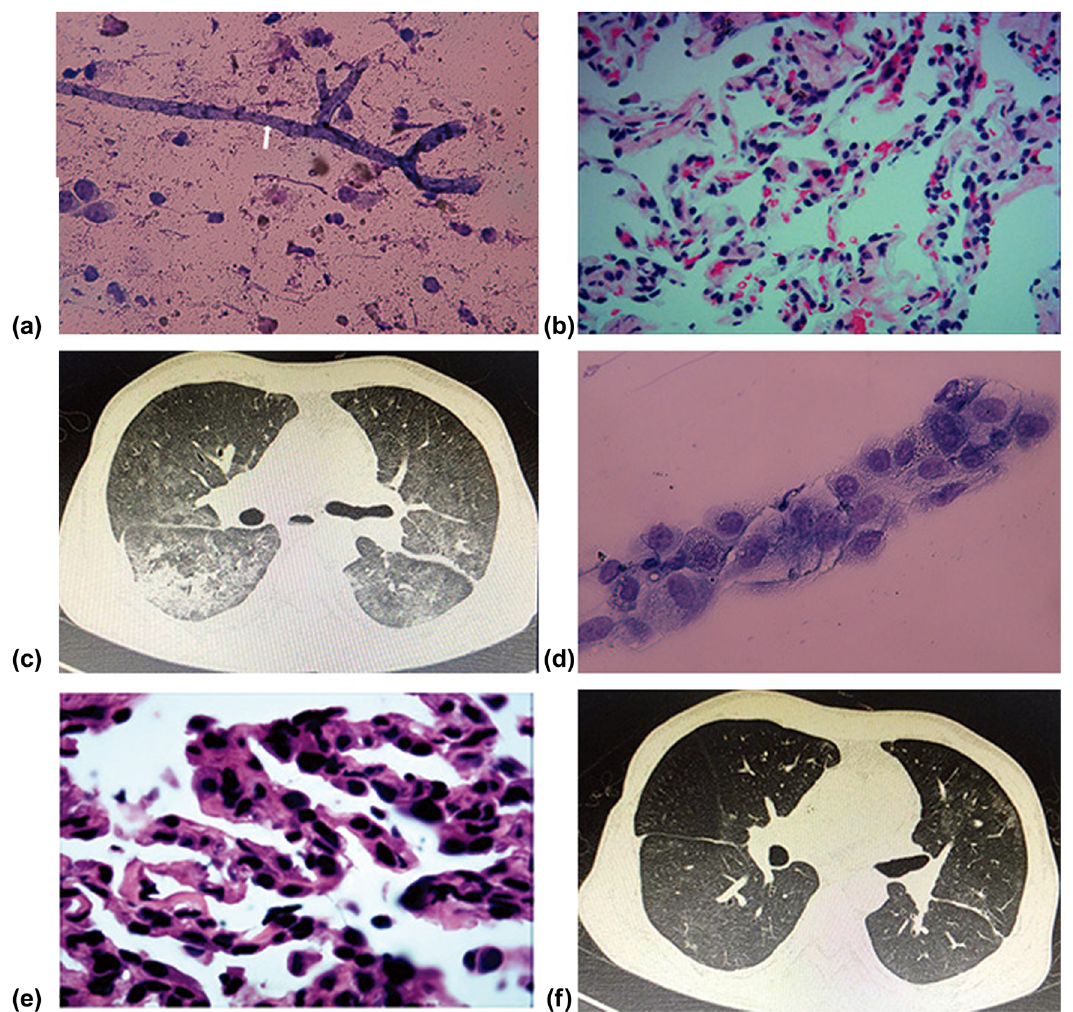
Figure 2: CT, ROSE, and histologic fi ndings of case 2 and